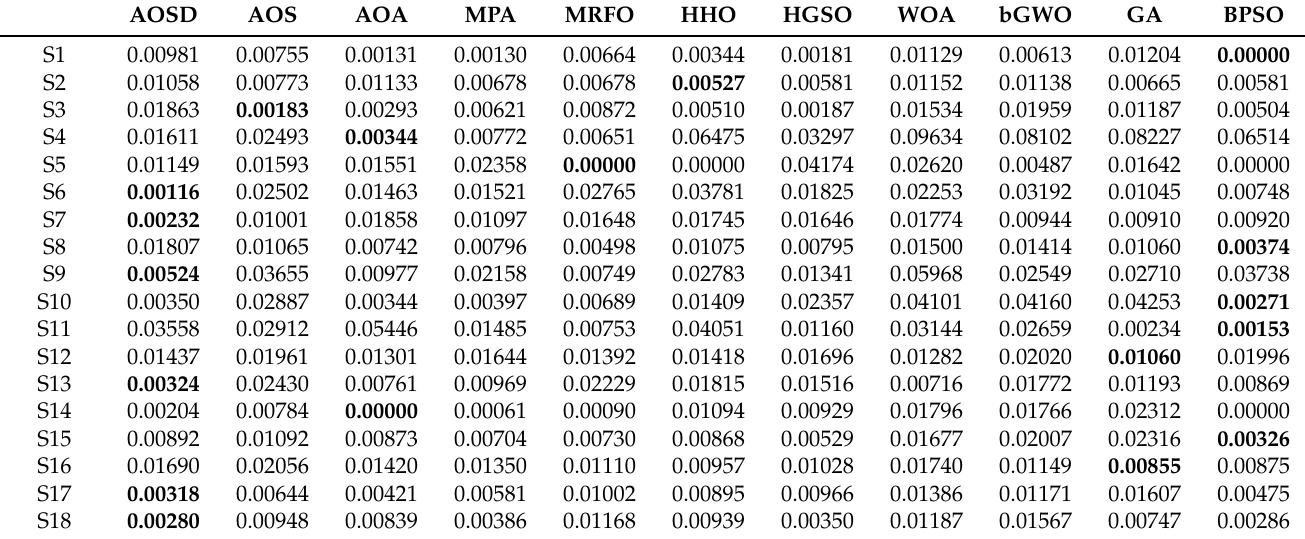
Table 4. Standard deviation of fitness values for FS